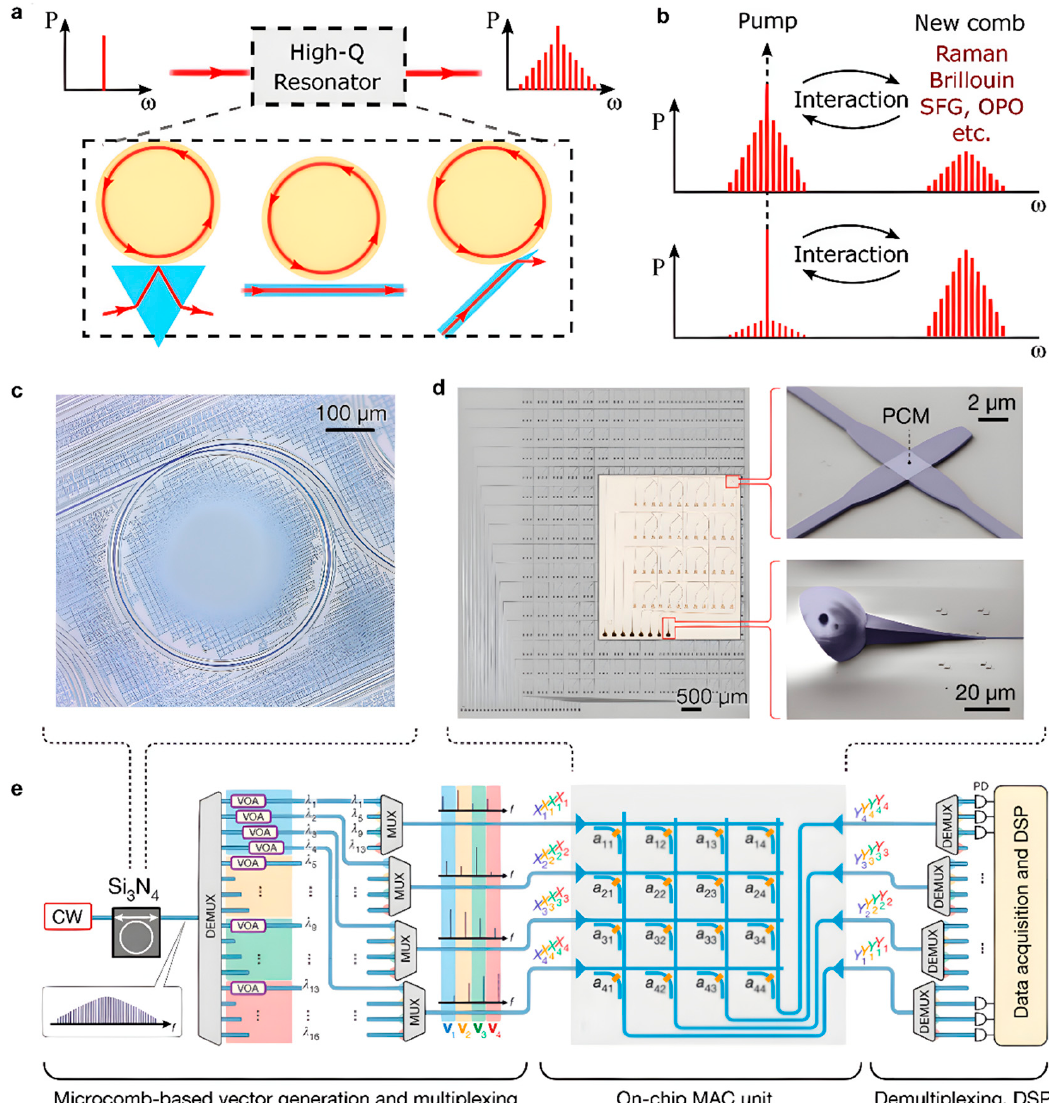
Figure 5. Computing Based on Soliton Microcomb . ( a ) Overview of high-Q resonator platforms for the generation of Kerr frequency combs [38]. ( b ) Illustration of Kerr comb interaction with other cubic and quadratic nonlinear effects [38]. ( c ) Sketch of the multiplexed all-optical MVM [31]. ( d ) Optical micrograph of a high-Q Si 3 N 4 photonic-chip-based microresonator used for frequency comb generation [31]. ( e ) Optical micrograph of a fabricated 16 × 16 [31]. ( a , b ) Reprinted with permission from Ref. [38]. © 2021 Wiley-VCH GmbH. ( c–e ) Reprinted with permission from Ref. [31]